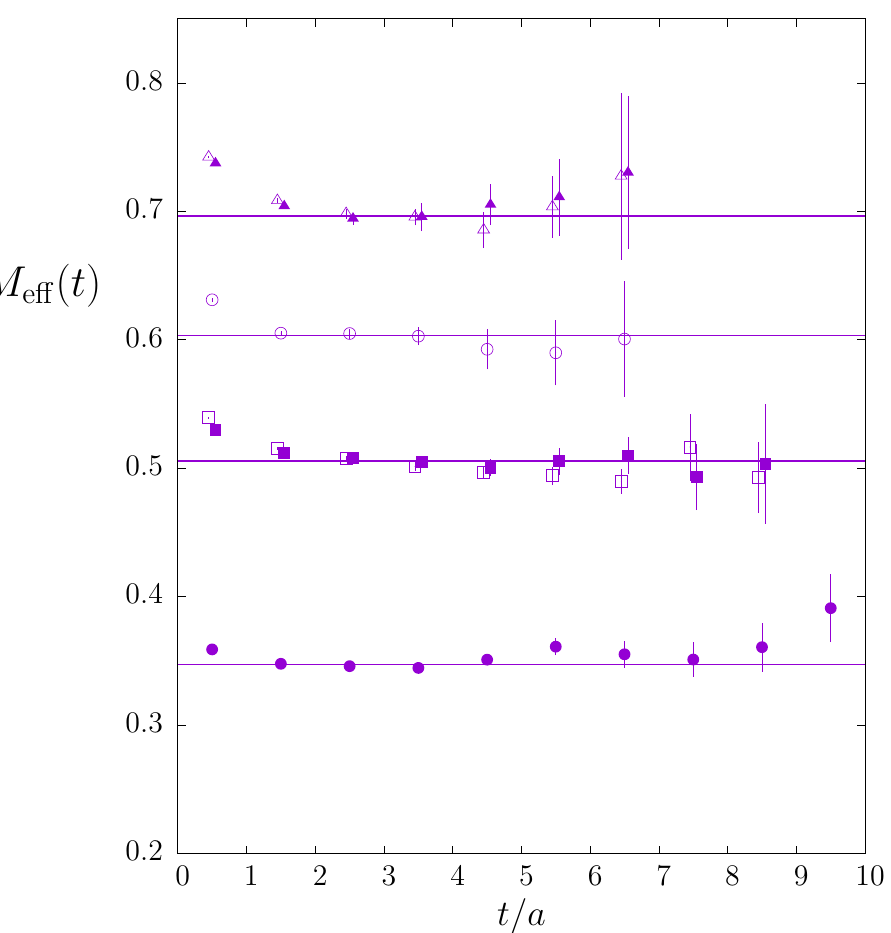
Figure 7 . Effective masses for the ground ( • ) and first excited ( ◦ ) J PC = 0 ++ states. Also the ground and first excited J PC = 2 ++ states: 2 of the 5 components from the E representation ( (cid:4) , N ) and the other 3 from the T 2 representation ( (cid:3) , M ). Some points shifted for clarity. Horizontal lines are our best mass estimates. On the 38 4 lattice at β = 6 . 50